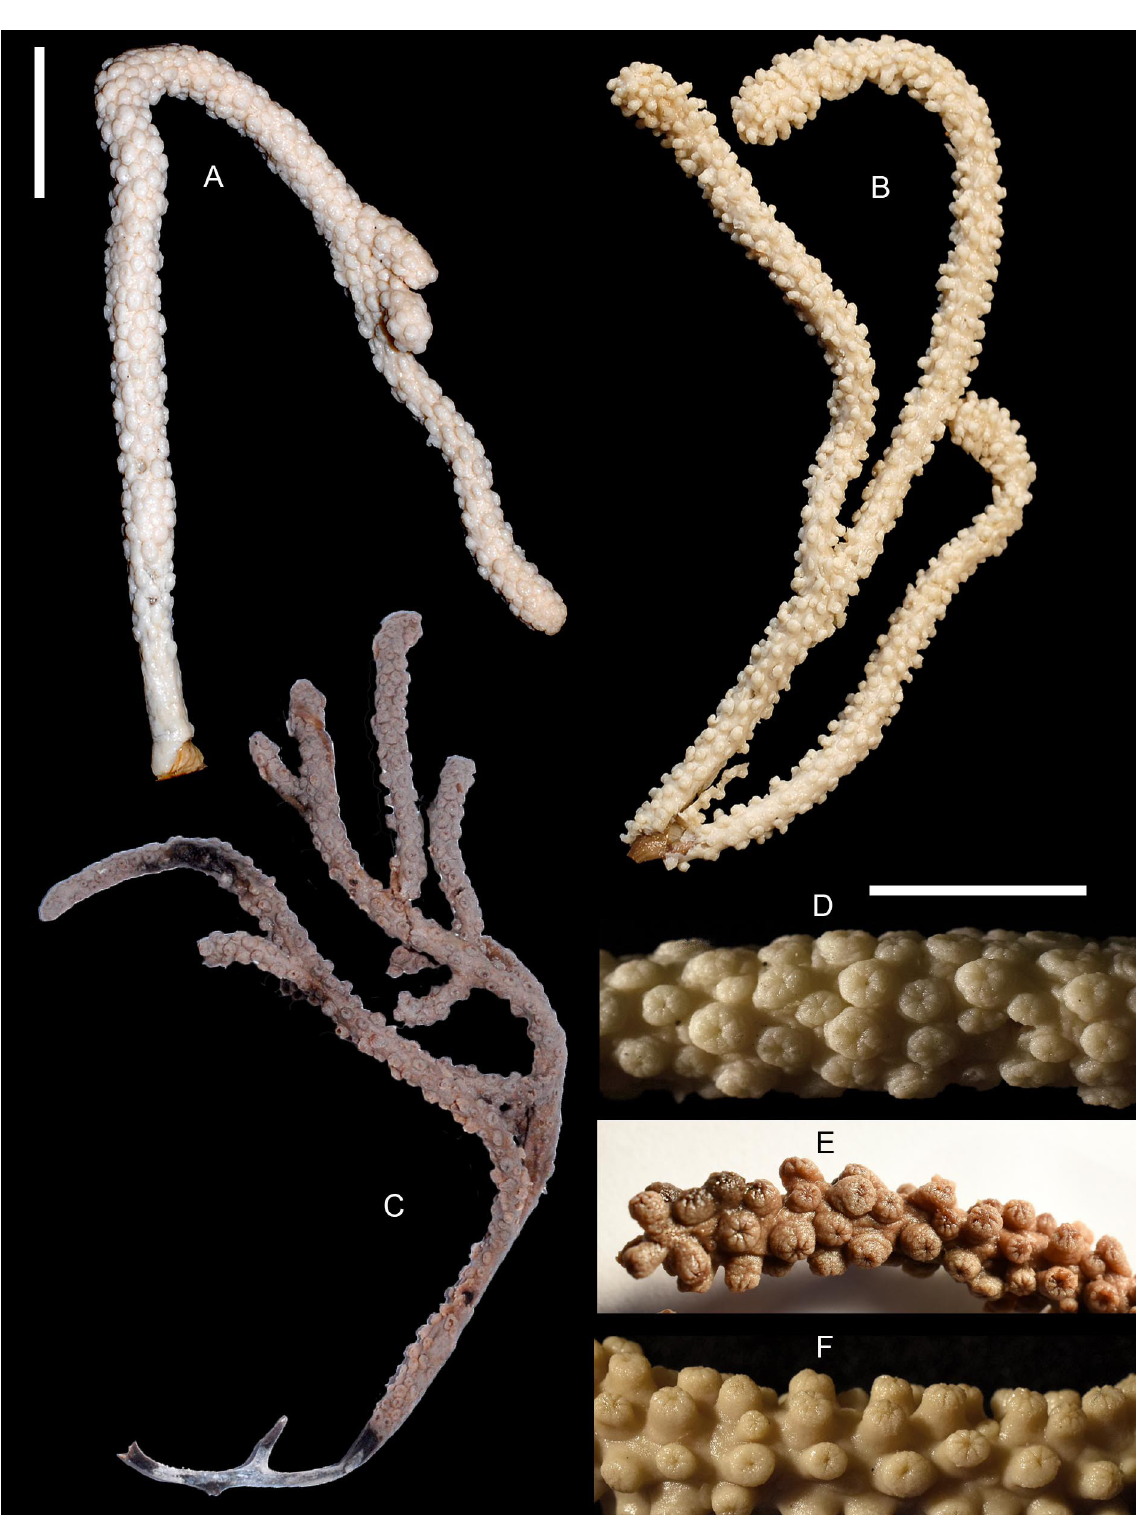
Fig. 8. Calcigorgia lukini sp. nov. A . Holotype MIMB 20710, Kurile Islands, Sea of Okhotsk. B . Paratype MIMB 20712, Kurile Islands, Sea of Okhotsk. C . Specimen from the Urup Is., Kurile Islands, Sea of Okhotsk, MIMB 20691. D . Side polyps, holotype MIMB 20710. E . Terminal polyps, MIMB 20691. F . Side polyps, MIMB 20743. Scale bars: A–C = 20 mm, D–F = 10